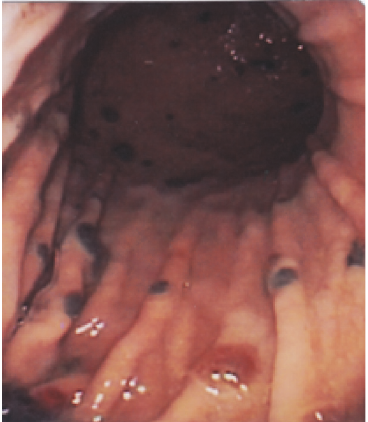
Figure 2: Melanotic lesions are less frequent in the distal part of the